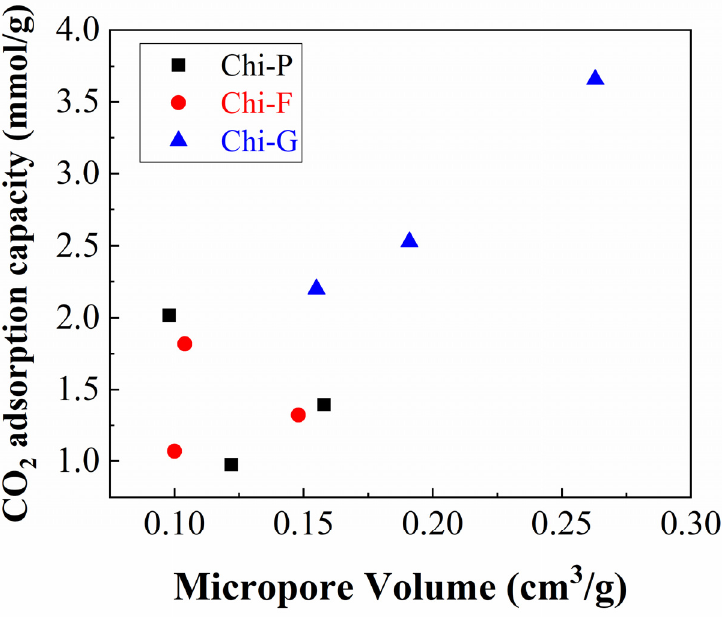
Figure 10. Representation of the CO 2 adsorption capacity at 1 bar and 25 °C vs. micropore volume, determined from the CO 2 adsorption isotherm at 0 °C.